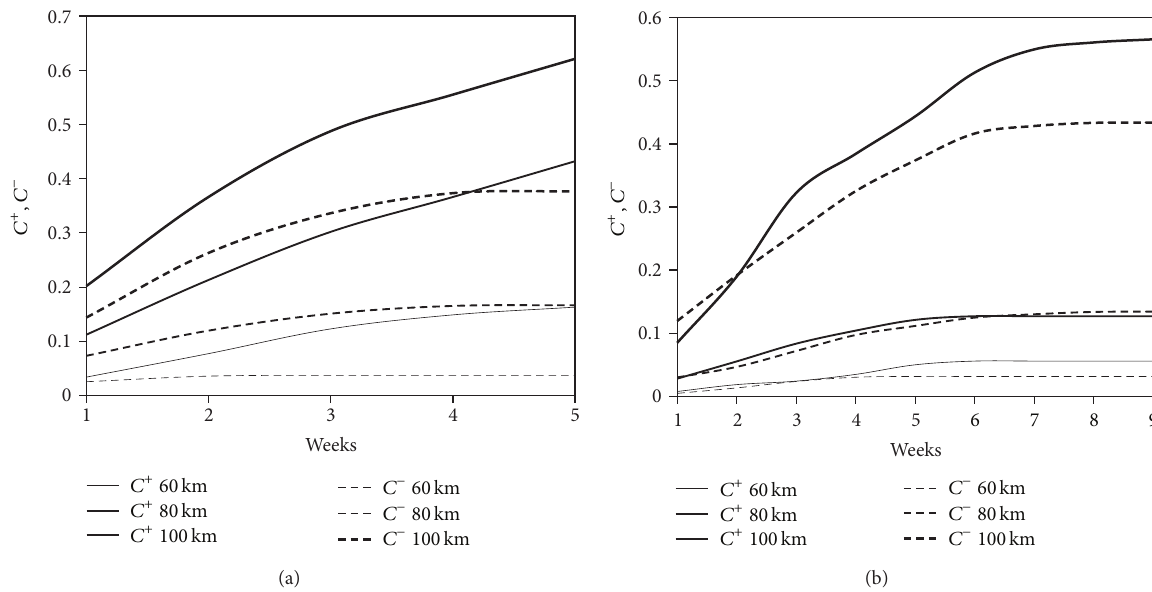
Figure 7: Evolution of the modified correlation integral for different time windows, during the two monitoring period. (a) Monitoring time from May 9, 2011 to June 16, 2011, see Tables 1 and 2. (b) Monitoring time from July 5, 2011 to September 5, 2011, see Tables 5 and 6.